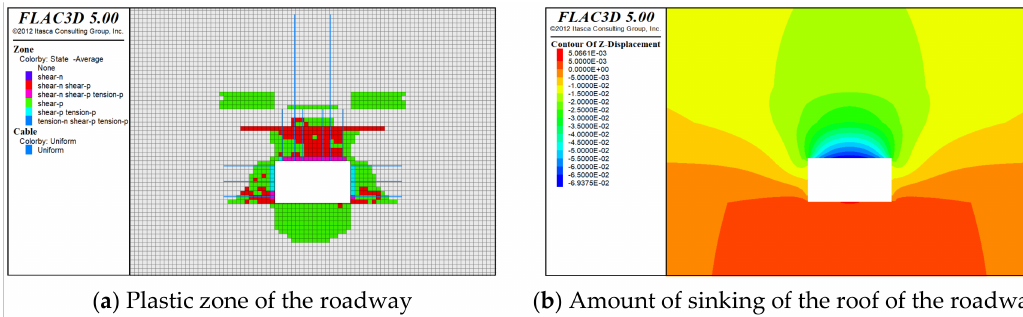
Figure 15. Cloud view of roadway with optimized support